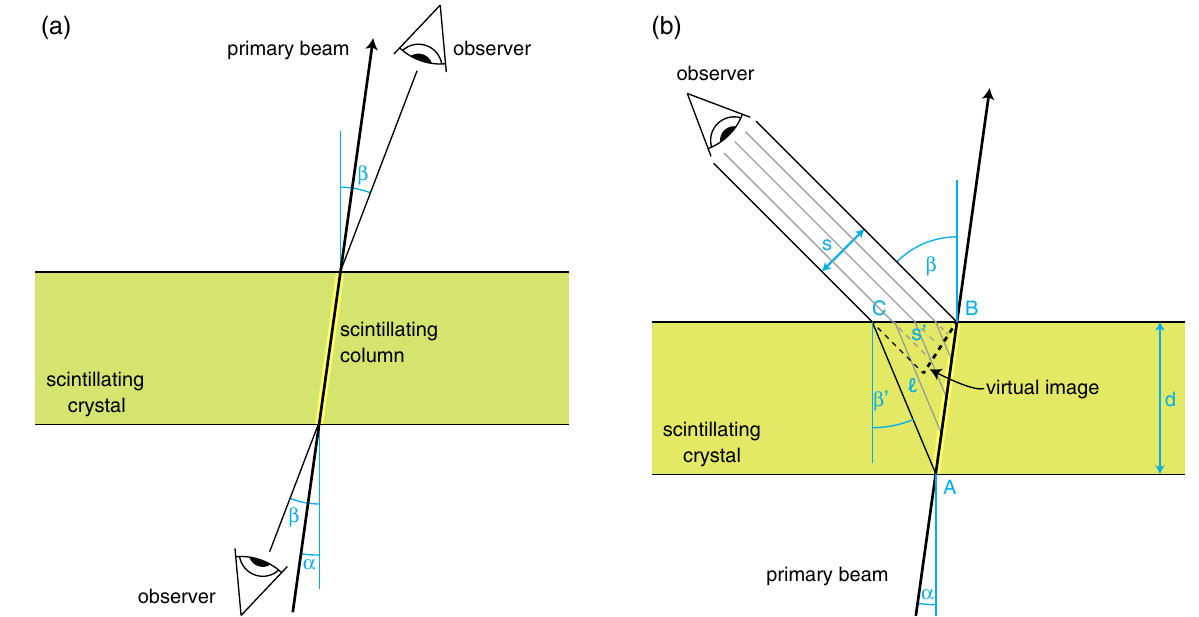
FIG. 2. Observation of light from a scintillating crystal. (a) Ideal observation angle, observing the Snell-Descartes law of refraction. (b) Situation for an arbitrary observation angle β